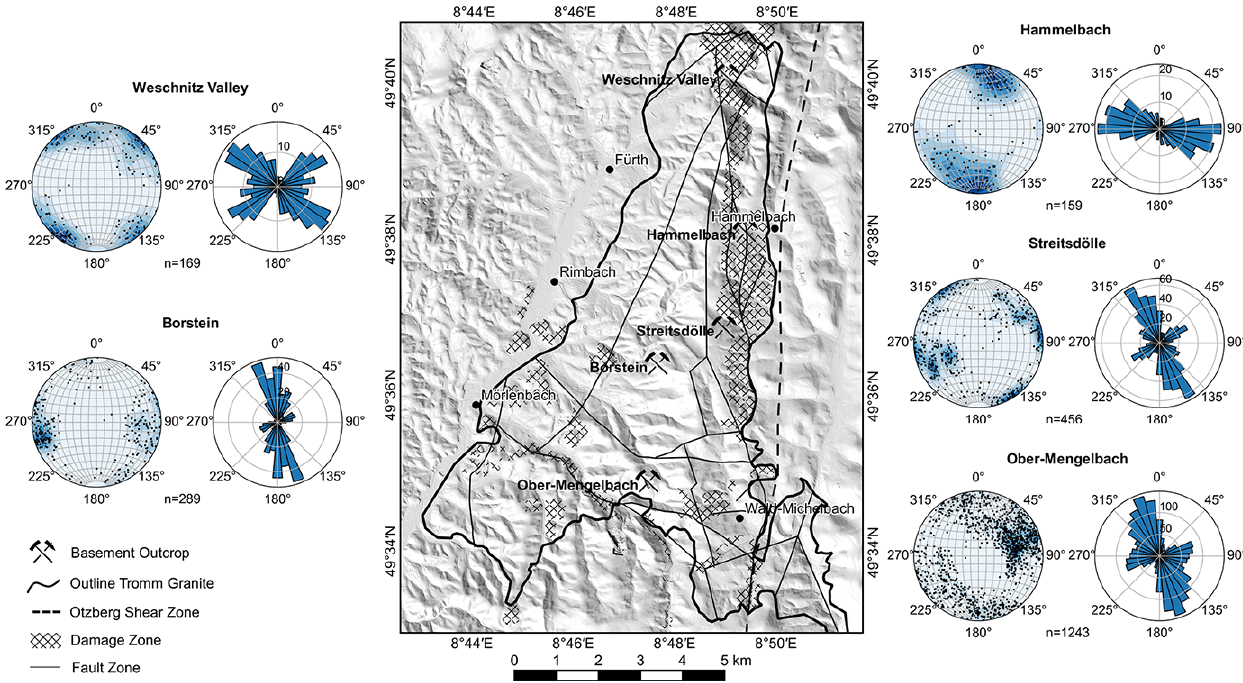
Figure 5. Summary of the outcrop analysis in the Tromm Granite area (faults and outline of the Tromm Granite from Klemm, 1900, 1928, 1929, 1933 and HLUG, 2007).